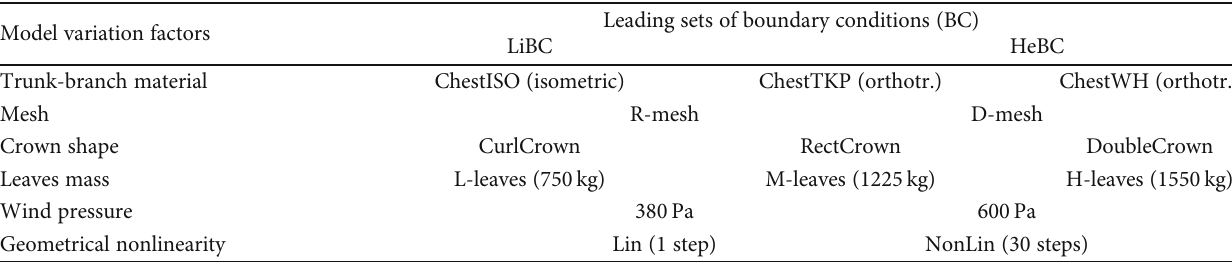
Table 1: Steps of model factors to